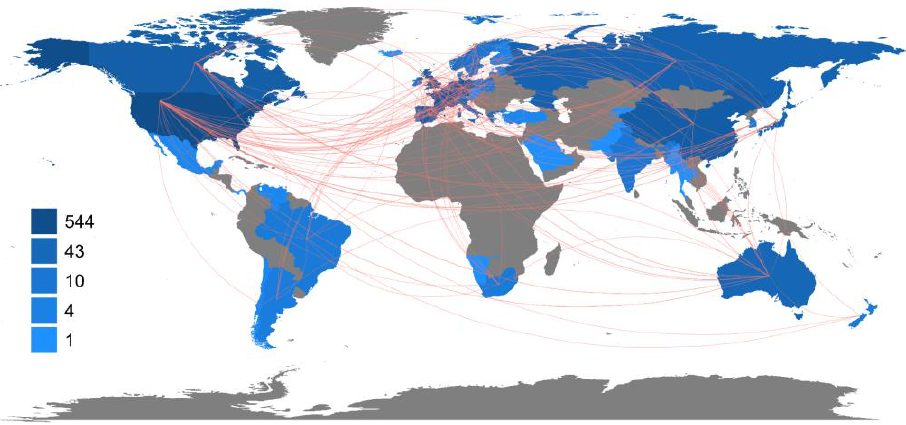
Figure 10. Bibliometric analysis of country/region collaboration from 1990 to 2022. More publications from the countries or areas are represented by a darker color. The red lines depict the cooperation relationships among the countries/regions.